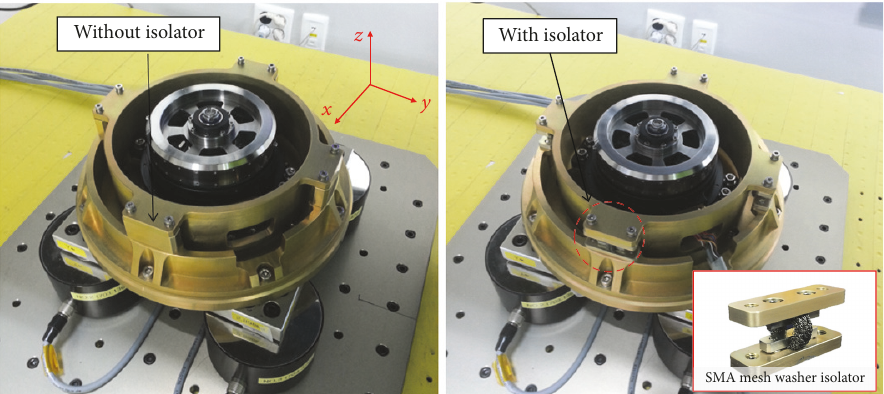
Figure 14: Test set-up for micro-jitter measurement of RWA with and without isolation system.